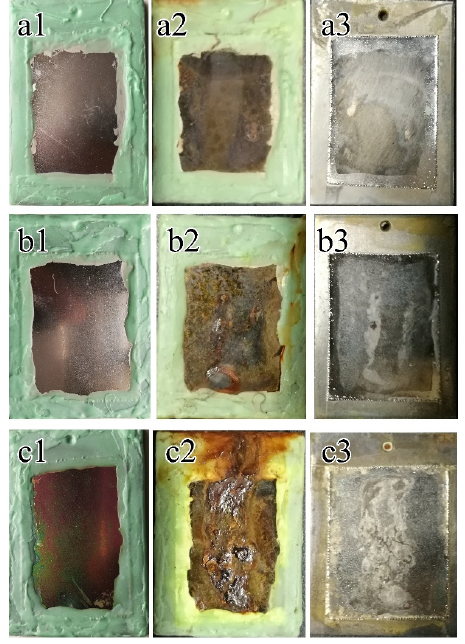
Figure 8. Corrosion results of samples deposited under SP. ( a1 ) as deposited; ( a2 ) as deposited after 1000 h test; ( a3 ) as deposited with corrosion product removed; ( b1 ) 300 °C treated; ( b2 ) 300 °C treated after 1000 h test; ( b3 ) 300 °C treated with corrosion product removed; ( c1 ) 400 °C treated; ( c2 ) 400 °C treated after 1000 h test; ( c3 ) 400 °C treated with corrosion product removed.